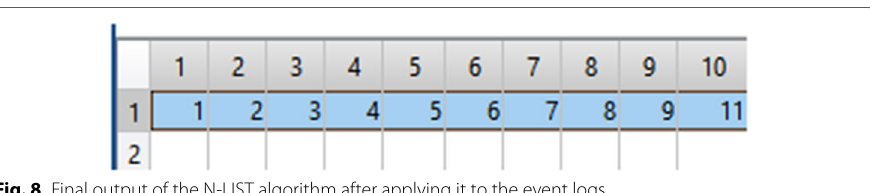
Fig. 8 Final output of the N-LIST algorithm after applying it to the event